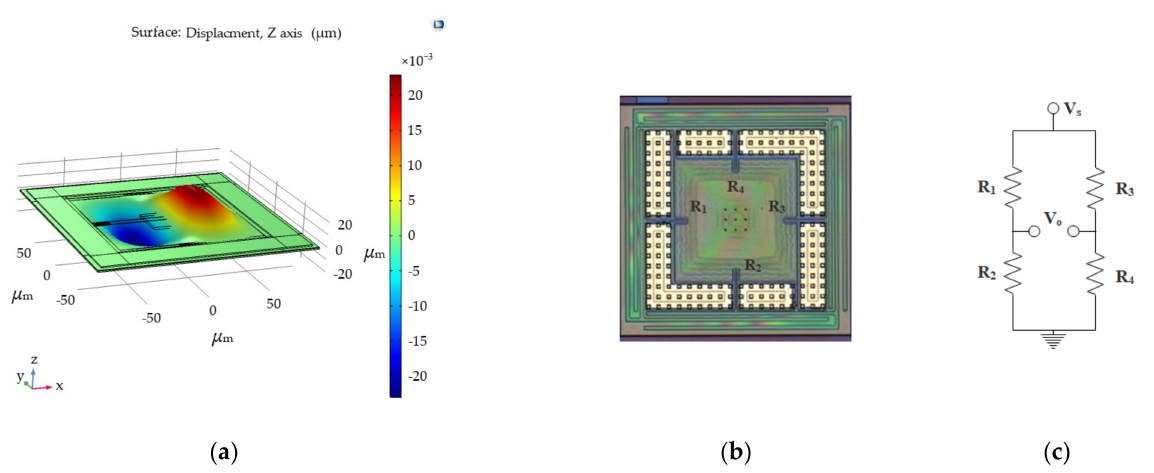
Figure 10. Shear force sensors developed by modifying routing of piezoresistive Wheatstone bridges. ( a ) When shear force in the x direction is applied on the center of the diaphragm, the left side of the diaphragm moves down while the right side moves up. ( b ) Released shear force sensor. ( c ) Wheatstone bridge of the shear force